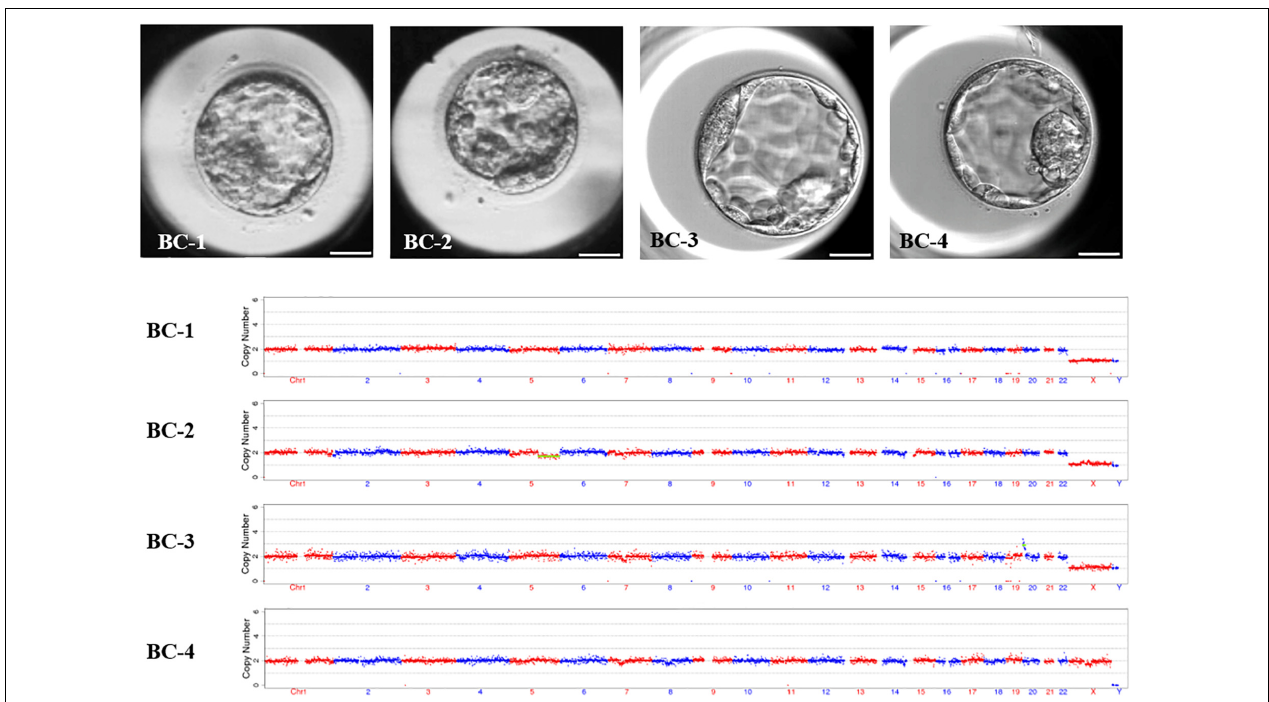
FIGURE 3 | The morphology and karyotype profile of blastocysts resulting from novel ICSI-AOA treatment. In order to detect the aneuploidy of the formed embryos, four blastocysts were selected to analyze the chromosome ploidy by whole-embryos aneuploidy analysis. The karyotypes of these four embryos were 46, XY; 46, XY, -5q (q21.1 → qter, ∼ 76M, × 1, mos, ∼ 30%); 46, XY, + 20p (pter → p12.2, ∼ 11.9M, × 3); and 46, XX; respectively. Scale bar = 50 µ